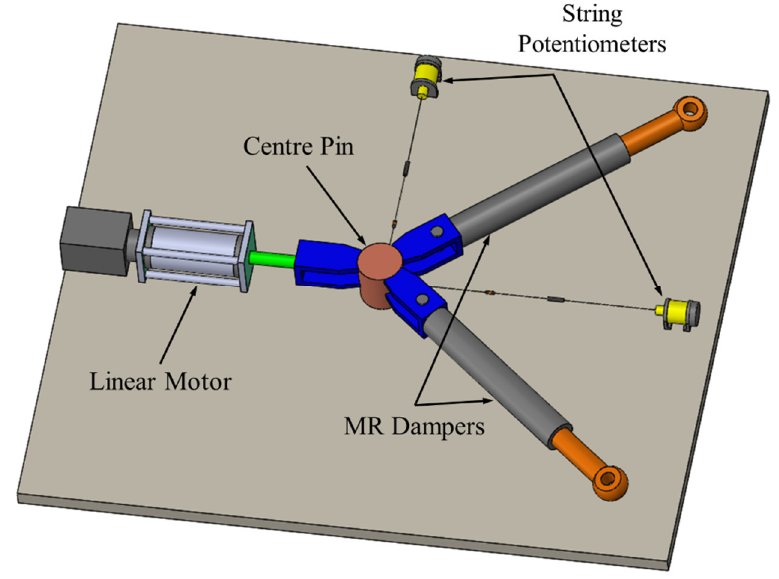
Figure 5. Schematic of parallel planar robot using MR damper [29].